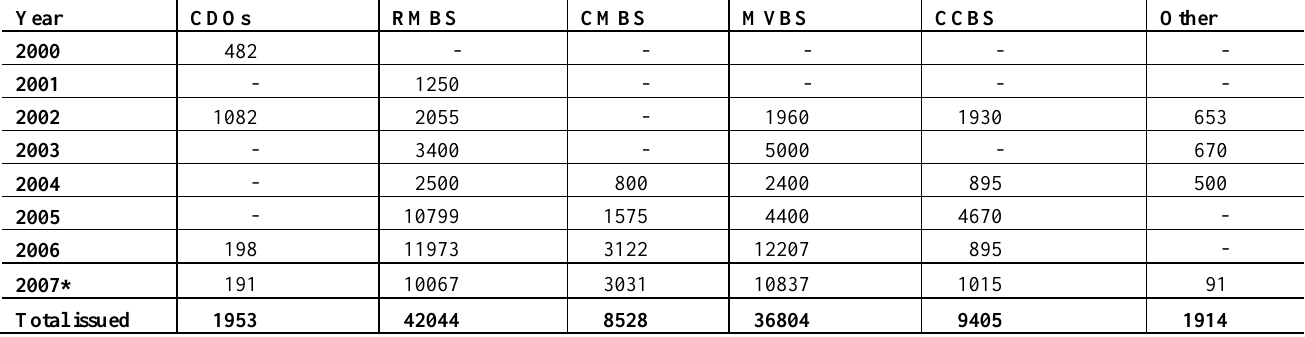
Table 2: Securitisation issuance by classification (R million)